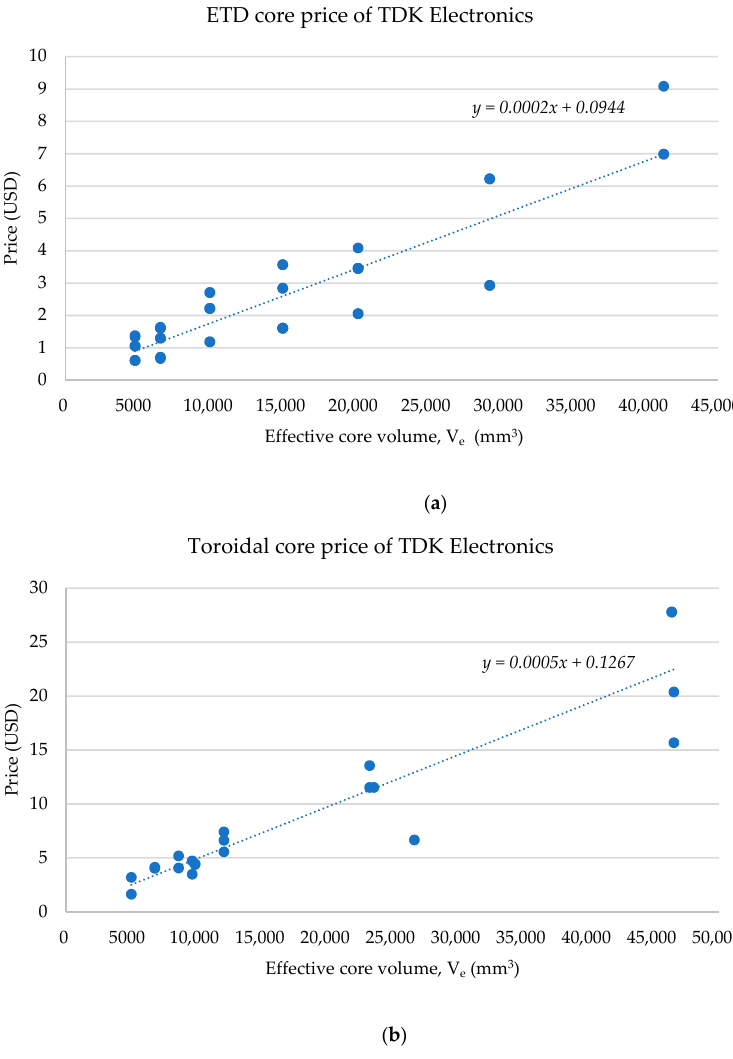
Figure 11. Price distribution of Ferrite core by effective volume: ( a ) ETD core for transformer; ( b ) Toroidal core for inductor.